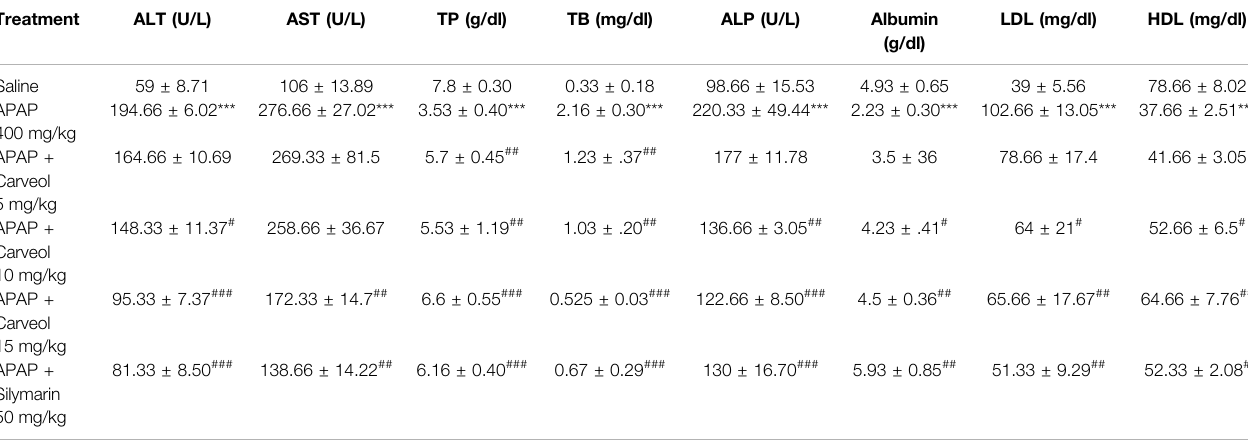
TABLE 1 | The protective effect of carveol on liver functional enzymes: APAP augmented the serum level of LFTs and attenuated high-density lipoprotein (HDL) level, while carveol, with respect to APAP, mitigated LFT levels and increased HDL levels. Treatment